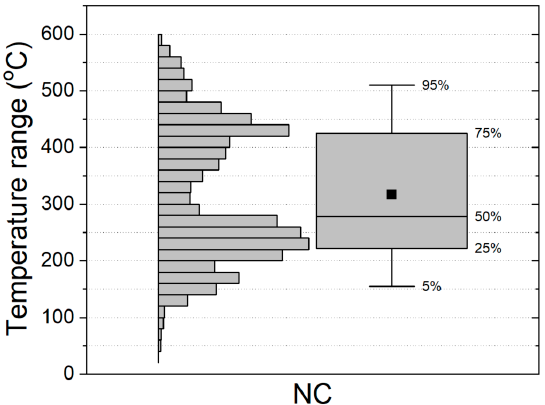
Figure 9. Temperature distribution based on the data acquired from the trailing/leading IR pyrometer during all the deposition time of a 300 mm-long wall with NC approached.